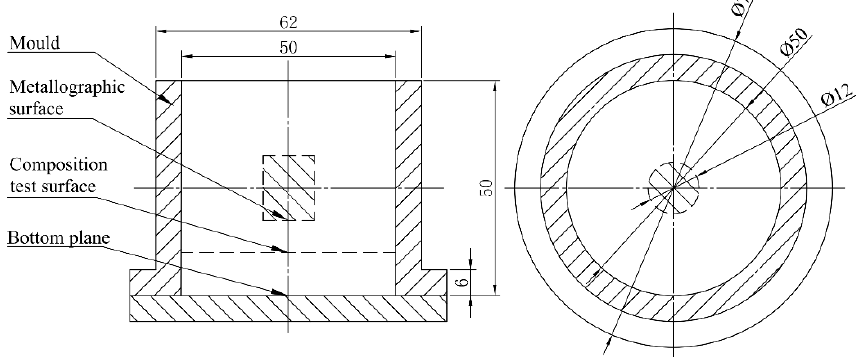
Figure 1. Schematic diagram of taking samples for composition test and microstructural observation (marked with the slash), all the dimension unit in figure 1 are mm.